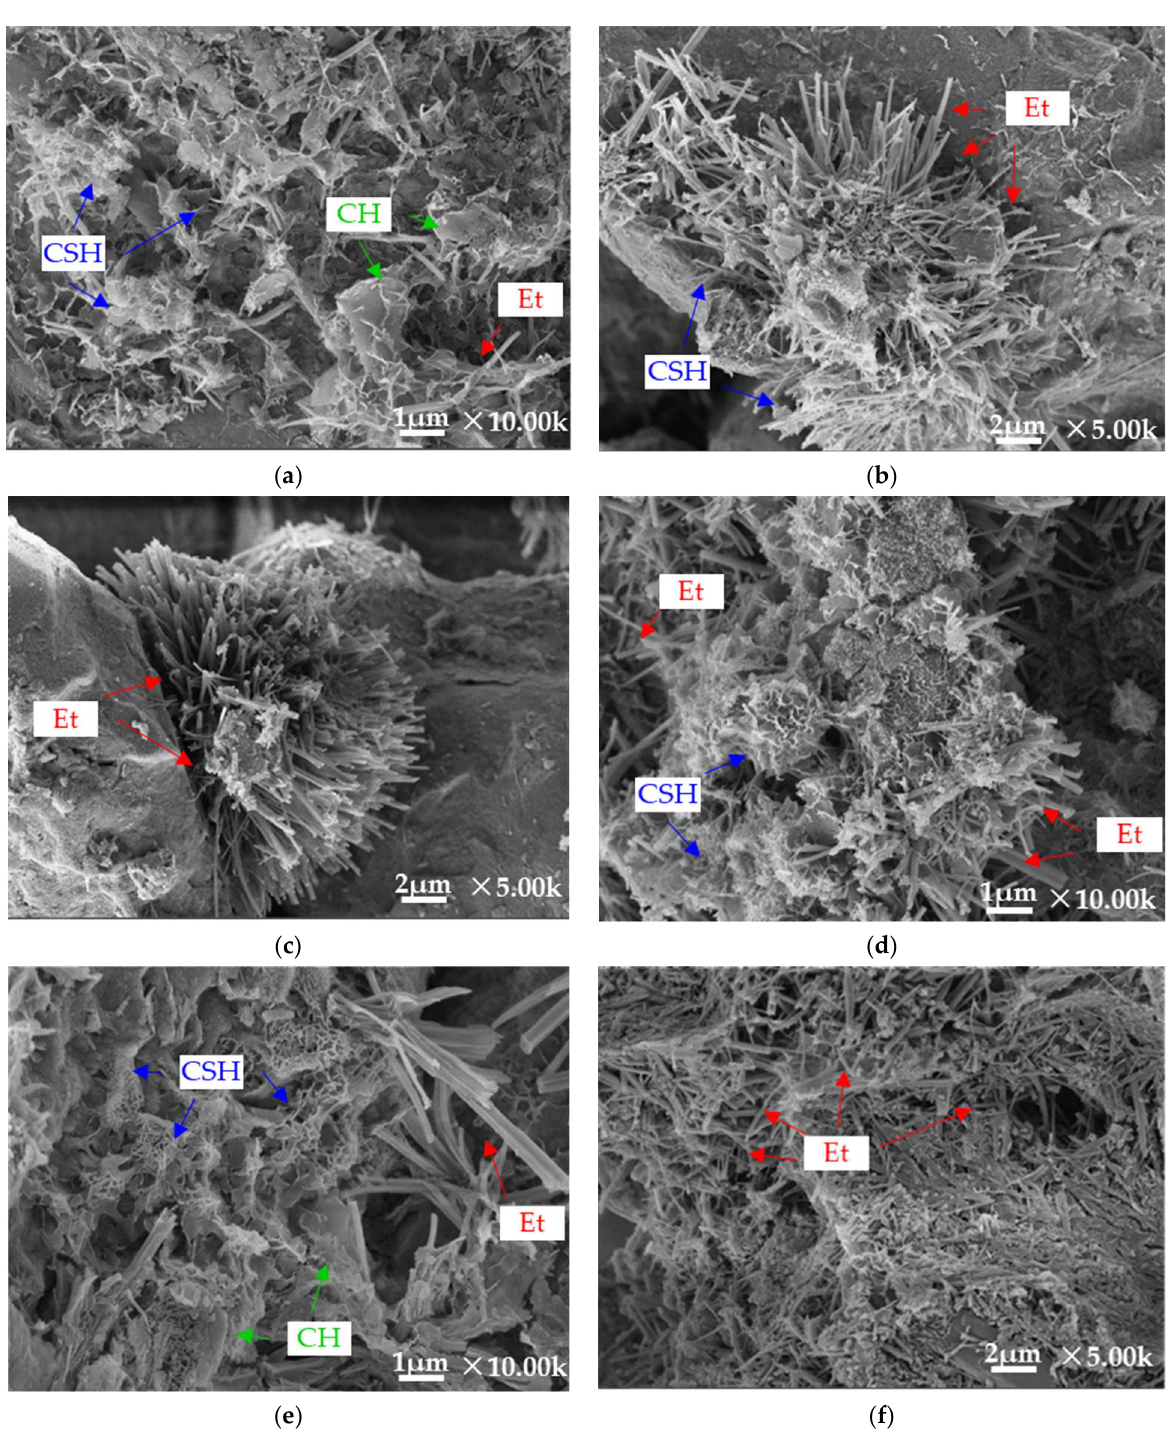
Figure 14. SEM images of stabilized silt, ( a ) B2(10%)-7d, ( b ) B2(10%)-28d, ( c ) B2(10%)-S28d, ( d ) B5(25%)-7d, ( e ) B5(25%)-28d, ( f ) B5(25%)-S28d. ( d ) B5(25%)-7d, ( e ) B5(25%)-28d, ( f )